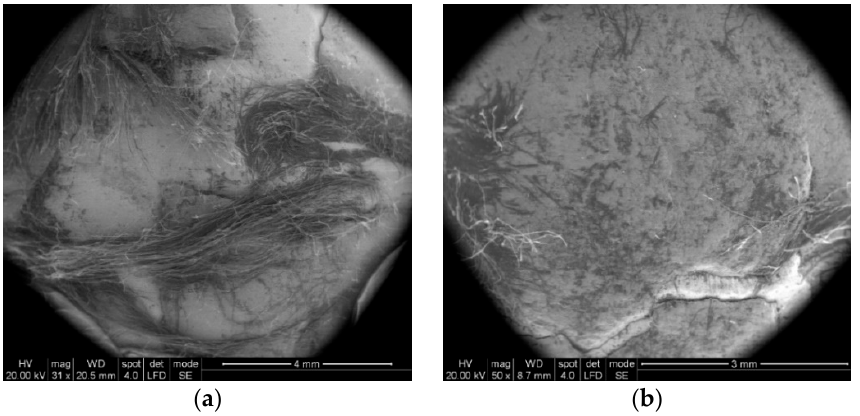
Figure 18. SEM details of bullet of 9 mm FMJ, as retrieved after firing. ( a ) Bullet of 2nd fire; ( b ) bullet of 3rd fire.